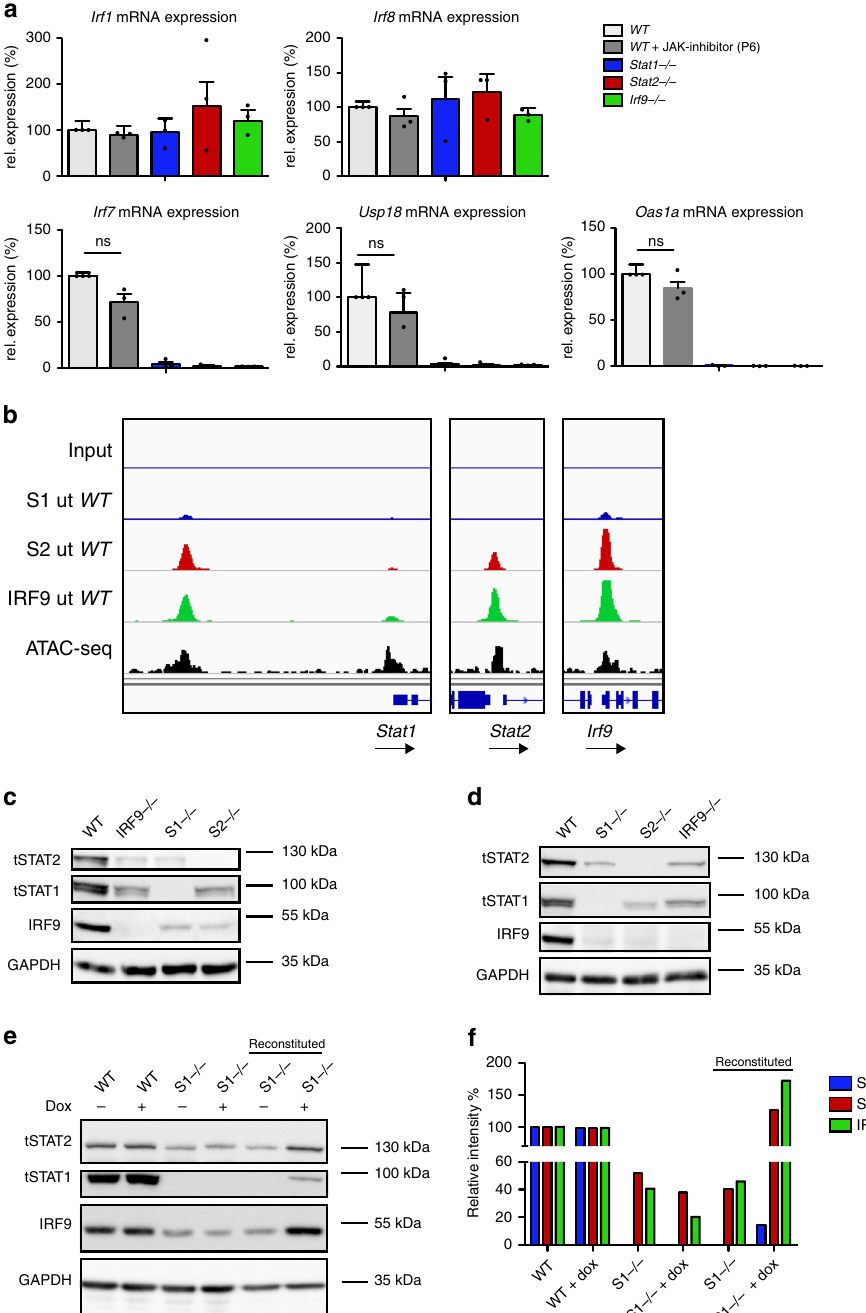
Fig. 7 Cross-regulation of ISGF3 subunits. a BMDMs isolated from WT, Stat1 − / − , Stat2 − / − , and Irf9 − / − mice were left untreated or treated with 15 µ M P6 inhibitor for 3 h. Gapdh-normalized gene expression was measured by RT-q-PCR. Data represent relative expression in percent, where WT untreated equals 100%. Data represent the mean and standard error of the mean (SEM) values of three independent experiments. P -values were calculated using the paired ratio t -test (* P ≤ 0.05; ** P ≤ 0.01; *** P ≤ 0.001). b STAT1 (S1), STAT2 (S2), and IRF9 binding at the Stat1 , Stat2 , and Irf9 promoters (scale 0 – 150). The browser tracks represent data derived from the ChIP-seq experiments in BMDM described in the legend of Fig. 2. c Whole-cell extracts from wild-type, Stat1 − / − , Stat2 − / − , and Irf9 − / − BMDMs were tested by western blot for total STAT1, STAT2, and IRF9 levels. d Whole-cell extracts from wild-type, Stat1 − / − , Stat2 − / − , and Irf9 − / − mouse embryonic fi broblasts were analyzed by western blot for total STAT1, STAT2, and IRF9 levels. e Stat1 − / − mouse embryonic fi broblasts were stably transduced with a doxycycline-inducible STAT1-myc construct. Whole-cell extracts from wild-type, Stat1 − / − , and reconstituted Stat1 − / − MEFs were tested by western blot for total STAT1, STAT2, and IRF9 levels in the absence and presence of doxycycline. f The representative blot in e was quanti fi ed using ImageJ. Relative intensities of the bands were normalized to their corresponding GAPDH levels. Data represent relative intensities in percent, where STAT1, STAT2, and IRF9 levels in untreated wild-type MEFs equal 100%. Source data are provided as